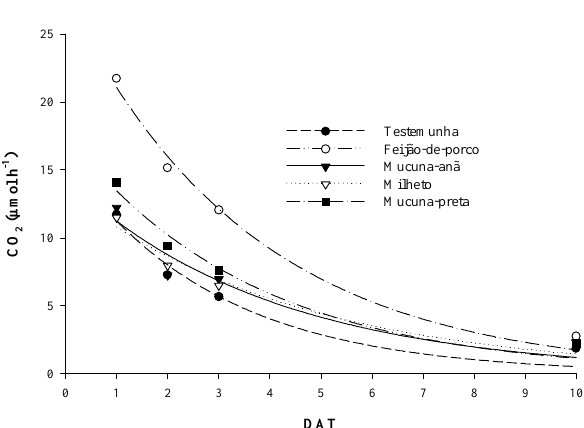
Figura 1. Valores médios de taxa de evolução de CO em solo rizosférico de feijão-de-porco, mucuna- anã, milheto e mucuna-preta, em relação à testemunha de solo não-rizosférico, aos 1, 2, 3 e 10 dias da aplicação (DAT) de 0,73 µg g -1 de